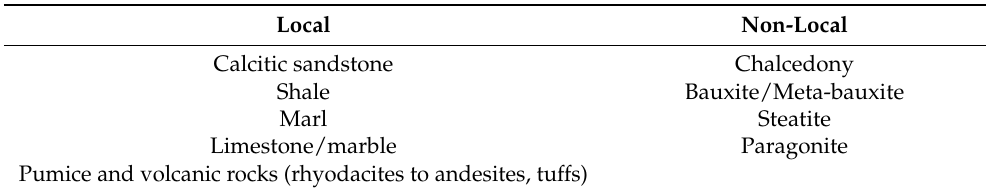
Table 4. Classification of the stone artefacts according to lithological characteristics of the raw material, in local and non-local. Local Non-Local Calcitic sandstone Chalcedony Shale Bauxite/Meta-bauxite Marl Steatite Limestone/marble